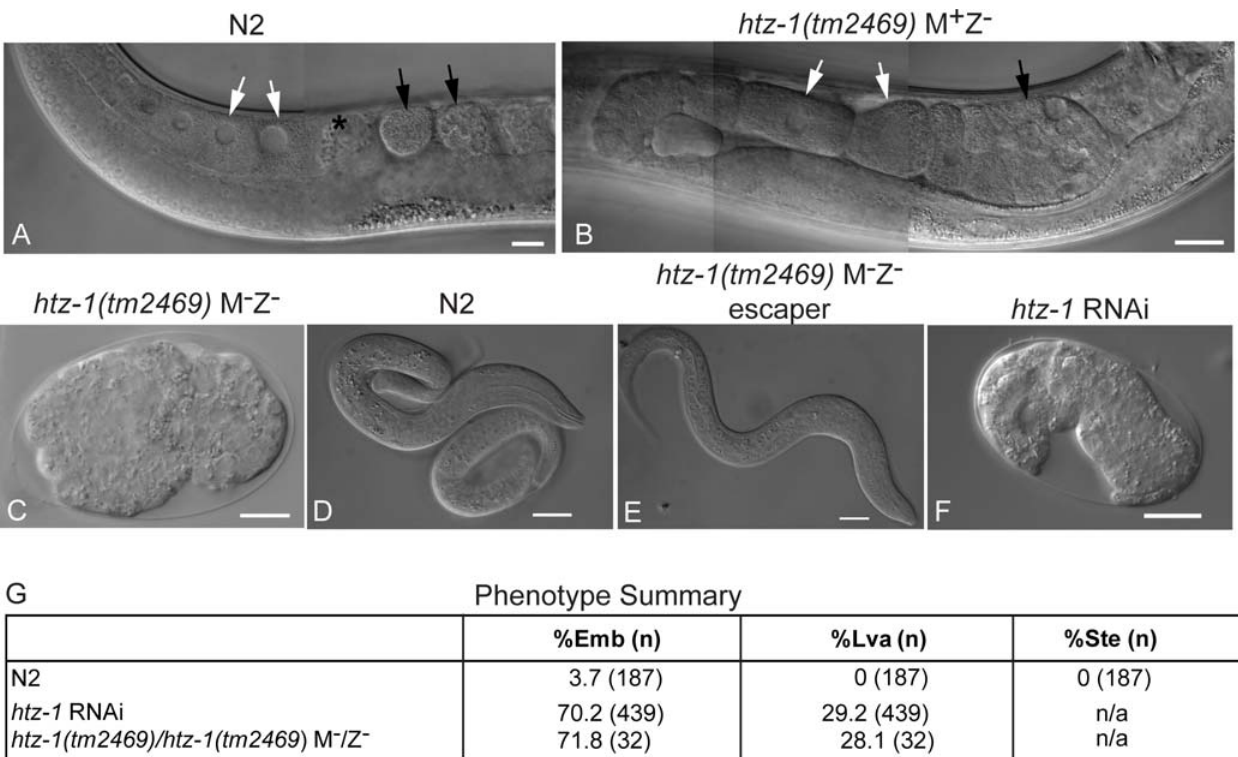
Figure 1. Maternal contribution of HTZ-1 is essential for development. Nomarski differential interference contrast (DIC) images of (A) N2 adult gonad, (B) htz-1(tm2469) M + Z 2 adult gonad, (C) htz-1(tm2469) M 2 Z 2 embryo (D) N2 embryo, (E) htz-1(tm2469) M 2 Z 2 arrested L1 larva, (F) htz-1 RNAi treated eri-1(mg366) embryos. White scale bars indicate 10 m m. (G) Summary of phenotypes for htz-1(tm2469) M 2 Z 2 and htz-1 RNAi. Emb, embryonic lethal; Lva, larval arrest; Let, lethal. Note that htz-1(tm2469) M 2 Z 2 embryos remain in utero , but were excised for examination by microscopy. White arrows indicate oocytes, black arrows indicate fertilized embryos, and the asterisk indicates the spermatheca.